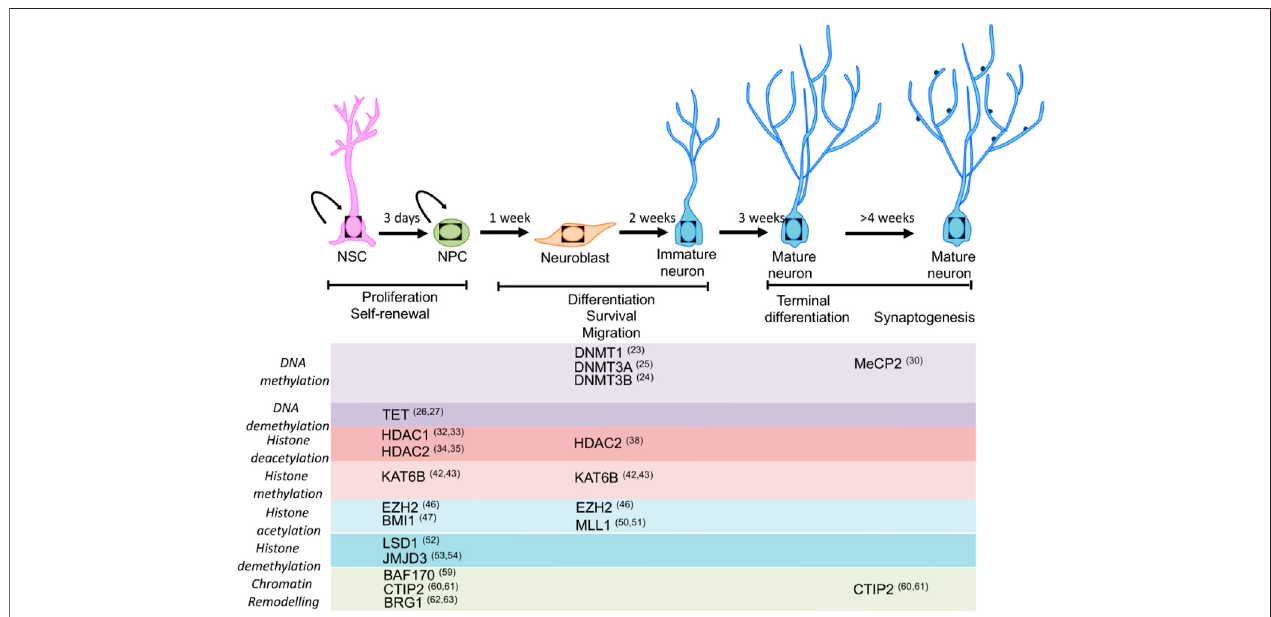
FIGURE 1 | Adult mammalian neurogenesis and the associated factors. The important steps are cell proliferation, differentiation, and survival, which are rhythmic and very sensitive to external stressors and cellular environment (Niklison-Chirou et al., 2020); copyright permission from Frontiers 2020.